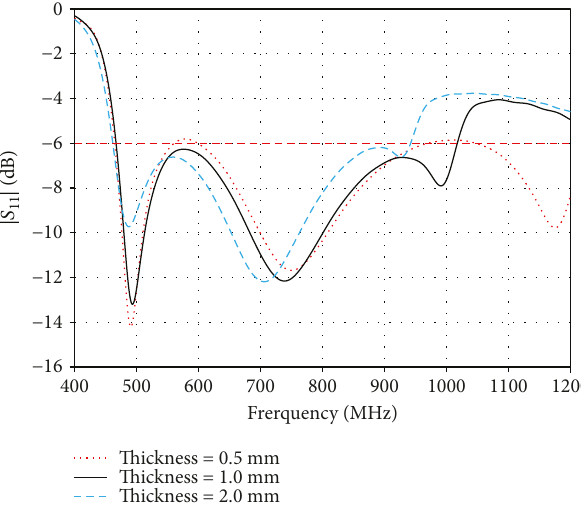
Figure 10: Simulated | S variable MD